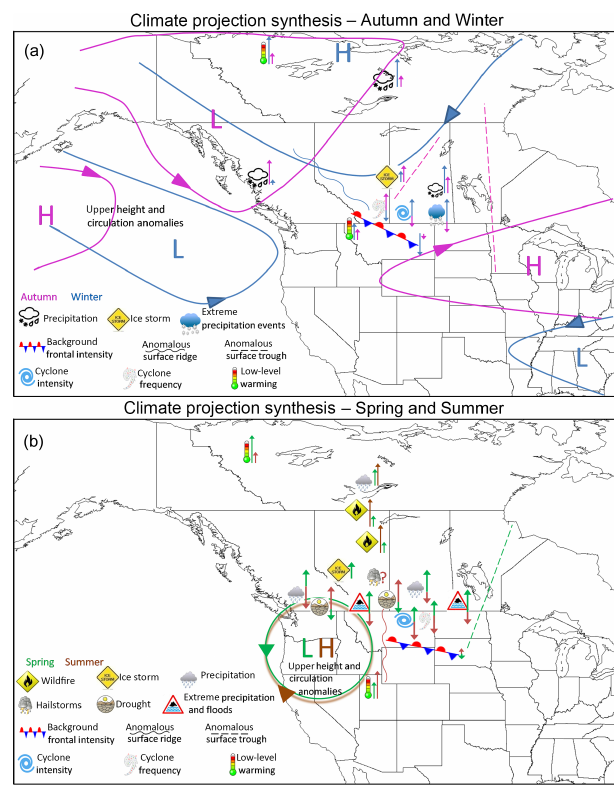
Figure 12. Conceptual depiction of upper-atmospheric, surface, and phenomena changes projected under the RCP8.5 emissions scenario by the end of the century during (a) autumn (purple) and winter (blue) and (b) spring (green) and summer (brown). Upwards (down- wards) pointed arrows indicate an expected increase (decrease). No arrow indicates no change and a question mark indicates uncer-